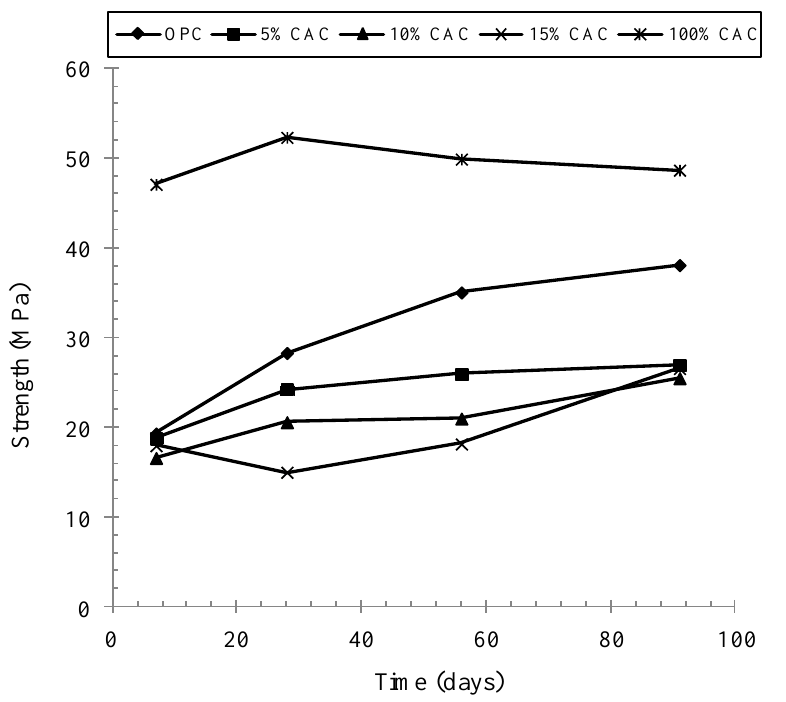
Figure 1. Development of compressive strength for mixtures of CAC and